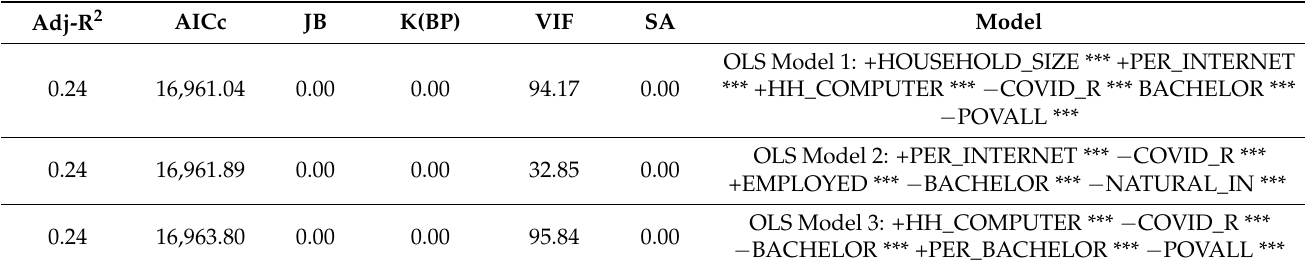
Table 2. The exploratory regression output report with the highest adjusted R 2 results when choosing six explanatory variables for ordinary least squares (OLS)